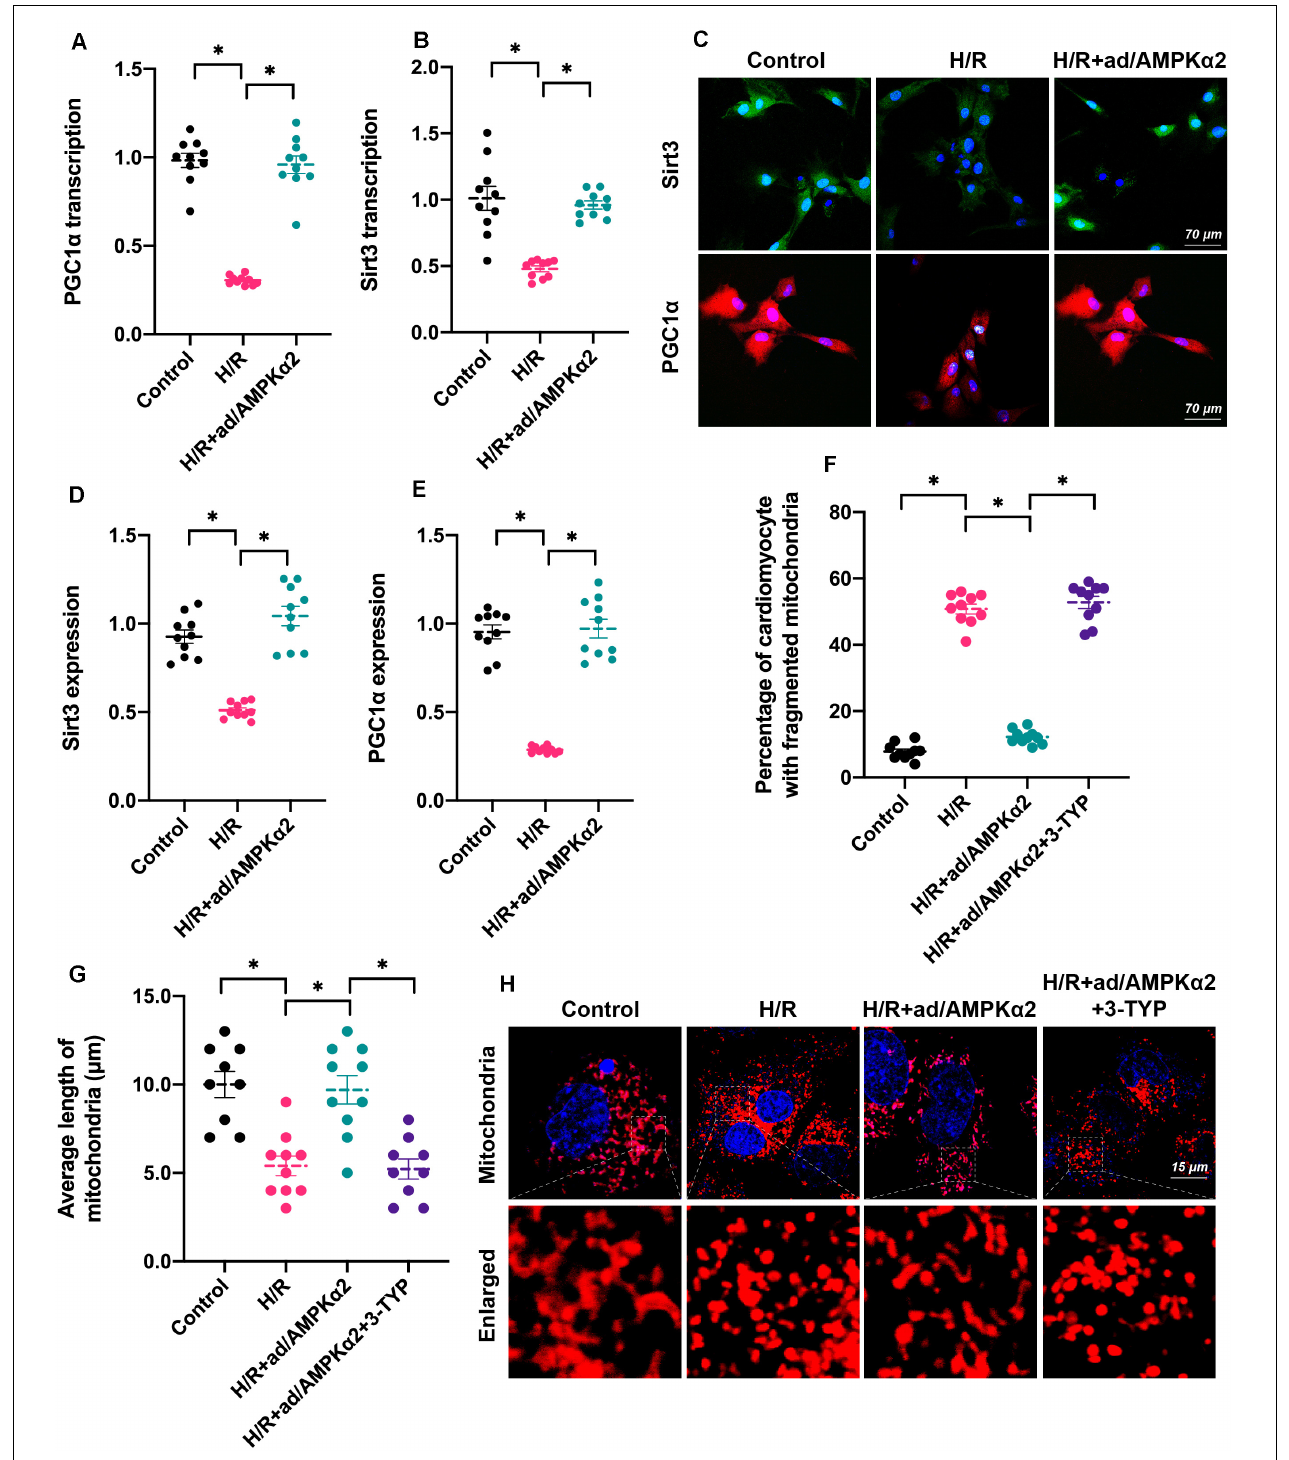
FIGURE 5 | AMPK2 α sustains mitochondrial dynamics through the Sirt3/PGC1 α signaling pathway. (A,B) RNA was isolated from cardiomyocyte, and qPCR was used to evaluate the transcription of Sirt3 and PGC1 α . (C–E) Immunofluorescence assay for Sirt3 and PGC1 α in cardiomyocytes treated with H/R injury. (F–H) Mitochondrial morphology was determined through immunofluorescence. 3-TYP, an inhibitor of the Sirt3/PGC1 α signaling pathway, was added into the cardiomyocyte medium before AMPK2 α overexpression. The data represent the mean ± SEM. P < 0.05.